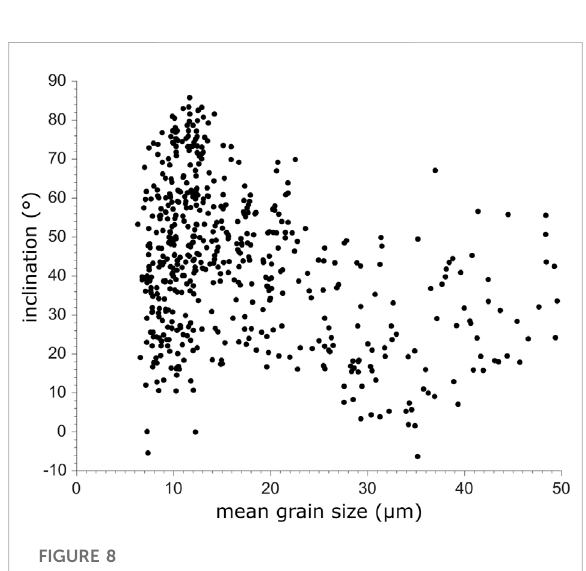
FIGURE 8 Inclination as a function of sediment mean grain size